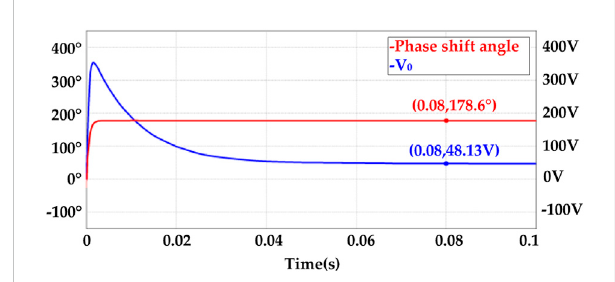
FIGURE 8 ThewaveformofoutputvoltageandthephaseshiftangleinWPT system without optimization.